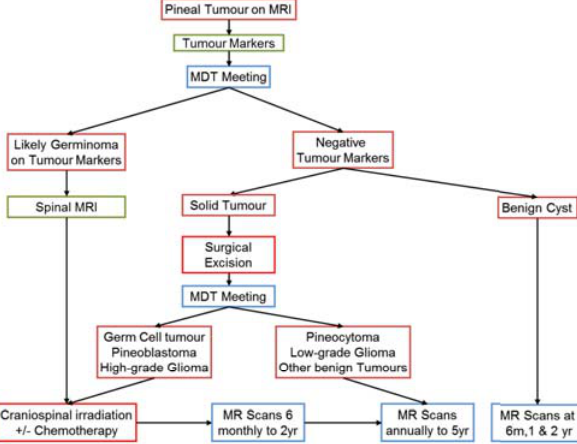
Figure 11. Flowchart management of patients with pineal region